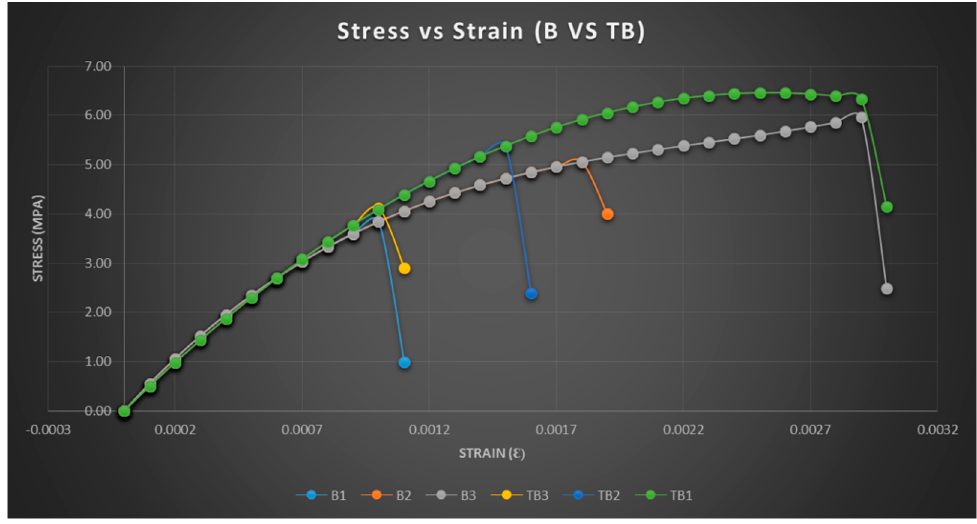
Figure 10. Comparison of the stress–strain curve for types B and TB.